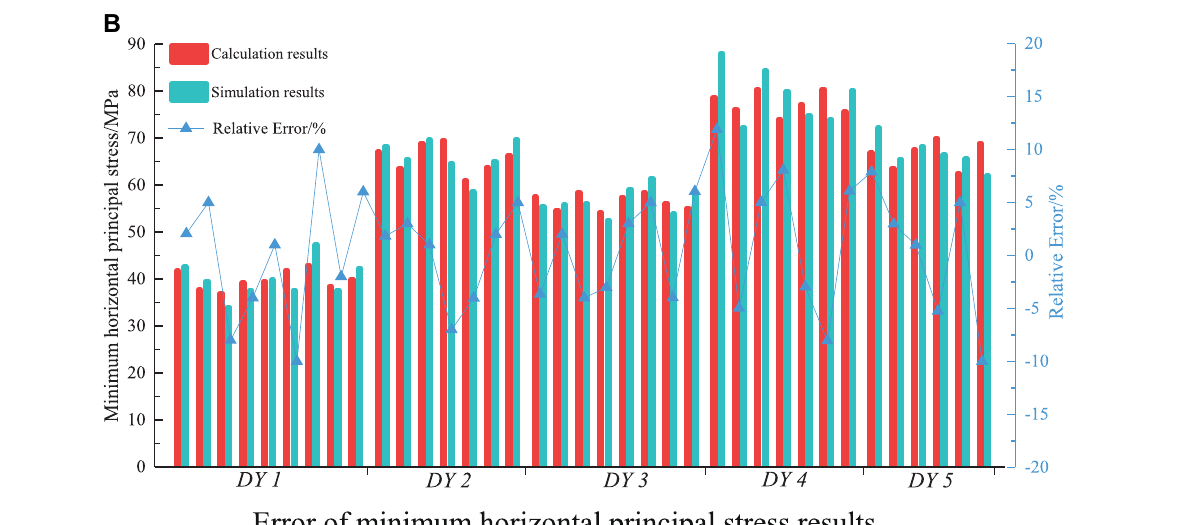
Frontiers in Earth Science |